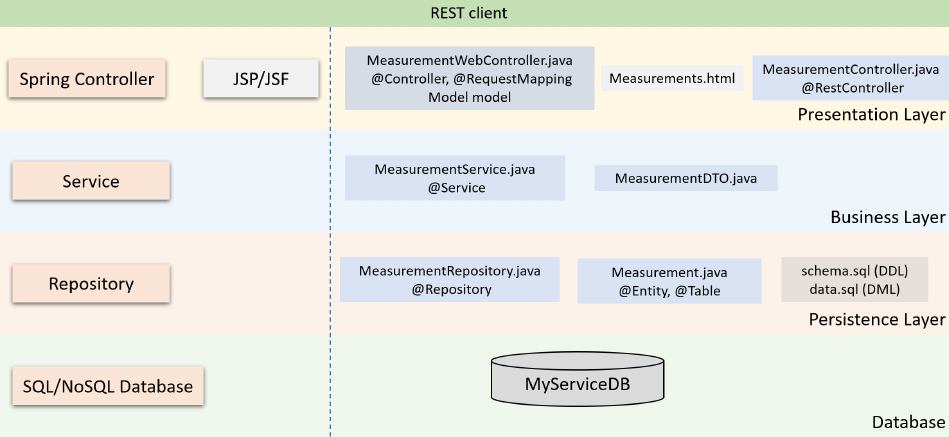
Figure 1. Multilayered architecture for shared data